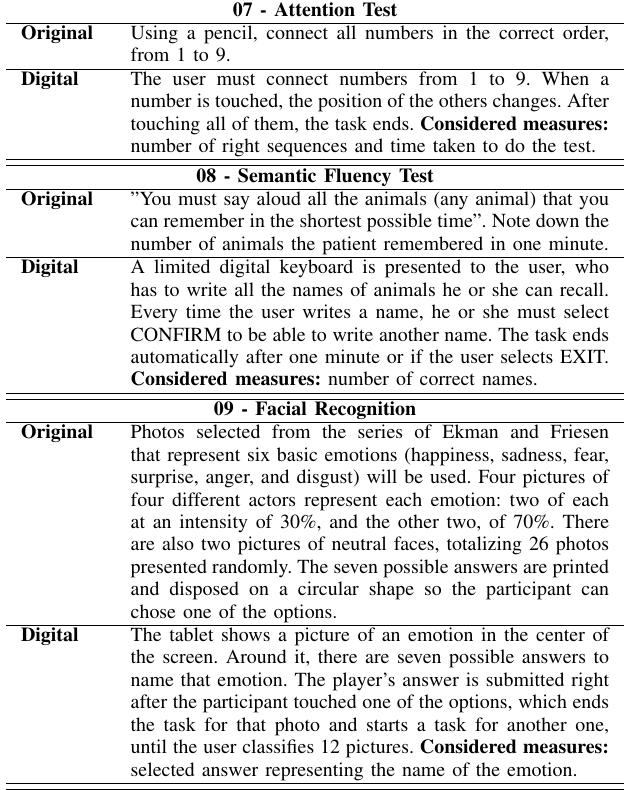
TABLE V C ORRELATED ELEMENTS BETWEEN PAPER - BASED TEST AND DIGITAL MODEL (C ONT .)